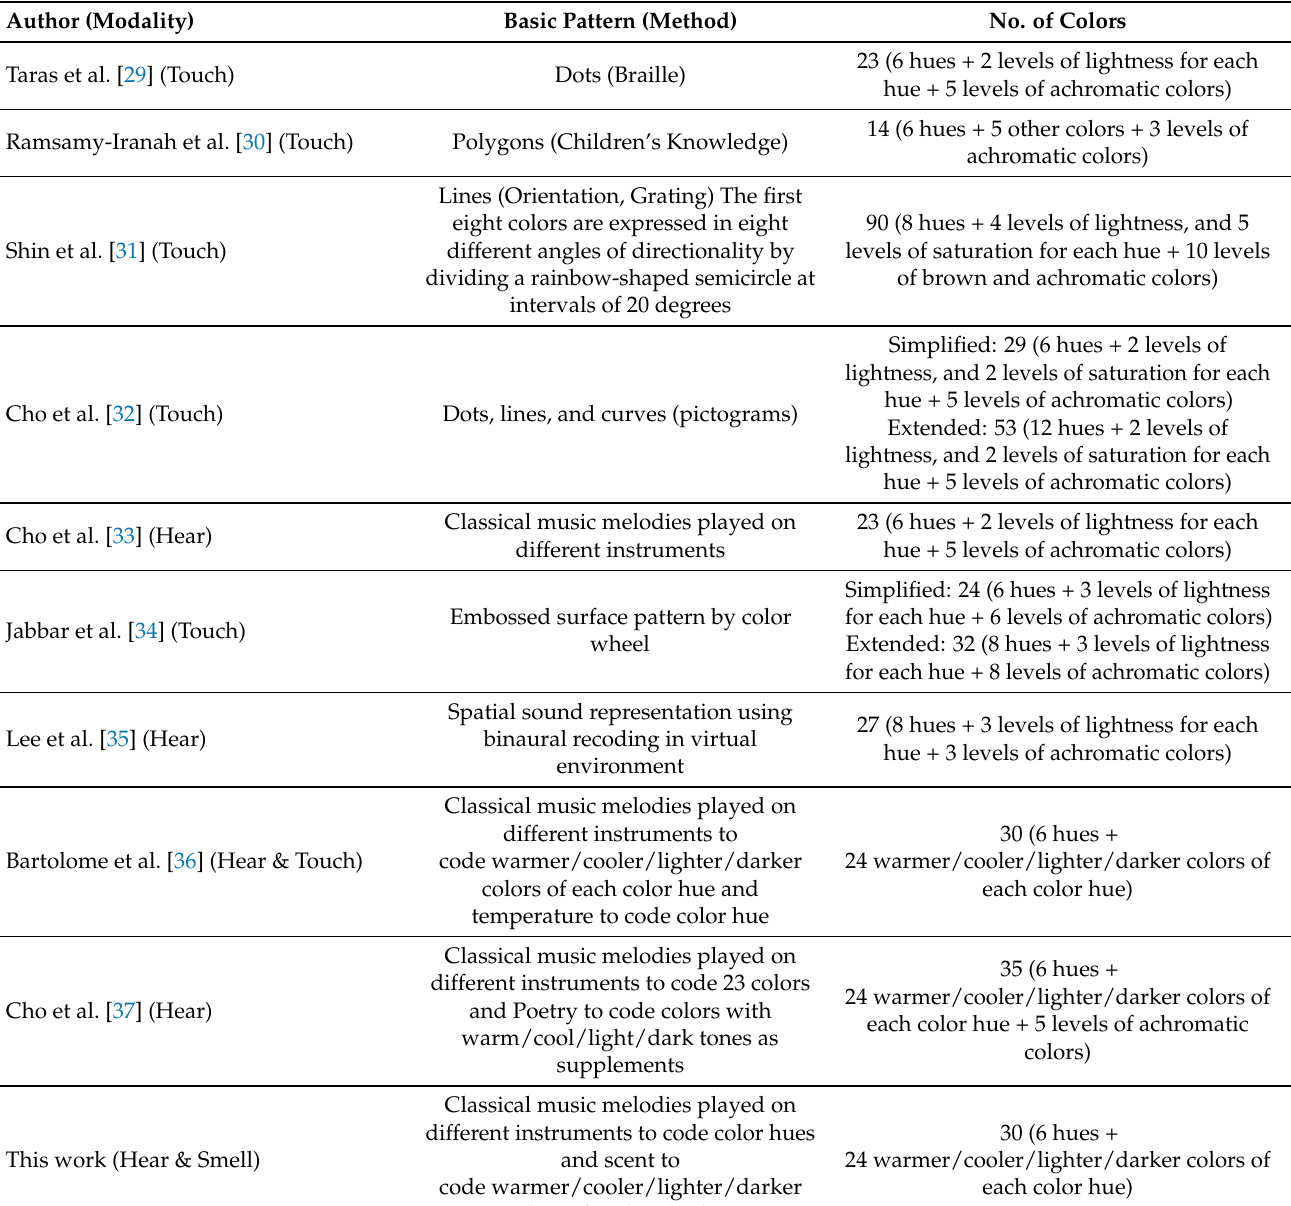
Table 1. Comparison of existing color codes in terms of coding method and the number of colors